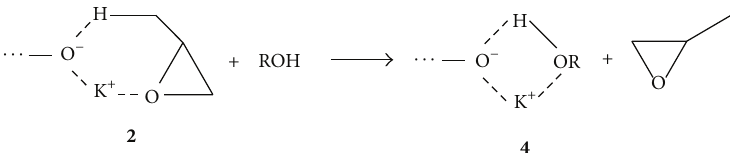
Scheme 1: Mechanism of the chain transfer reaction to the monomer.